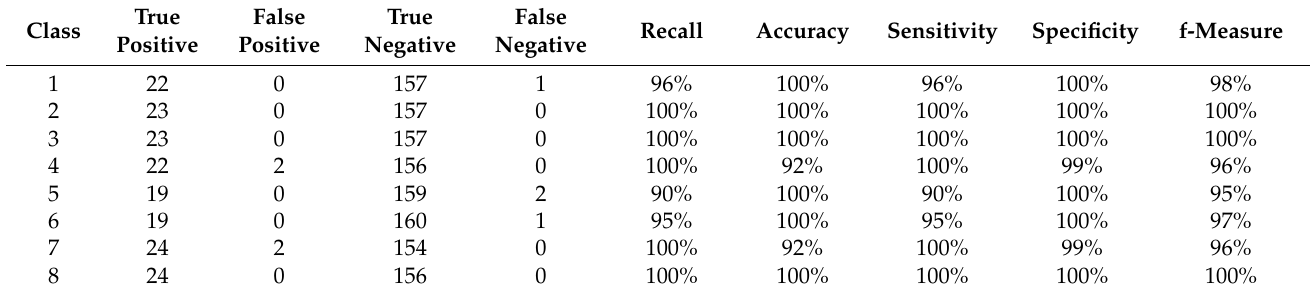
Table 6. Results of classification of eight investigated classes of PDs that applied Random Forest